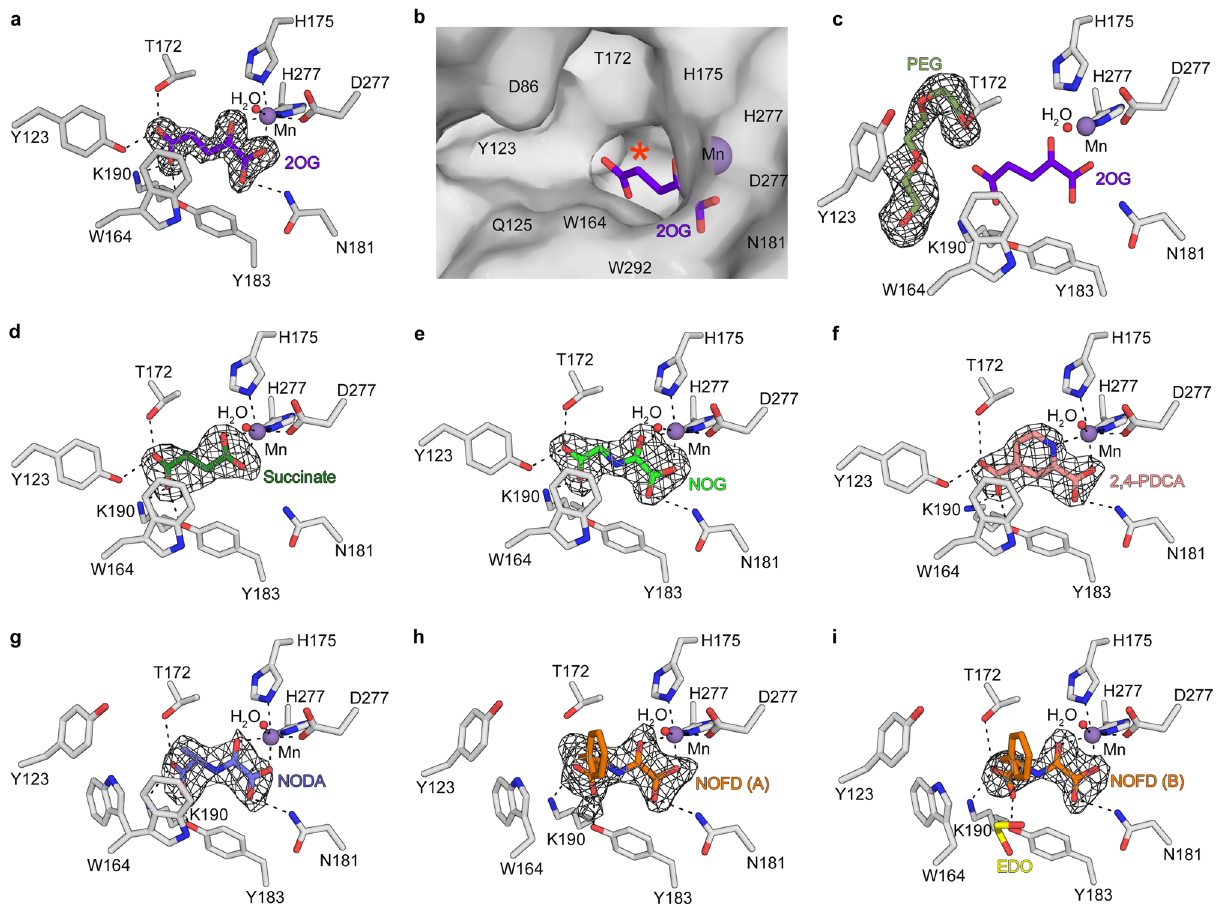
Figure 4. Views from the crystal structures of dmJMJD7.MnII complexes. Active site views from dmJMJD7.2OG ( A , B ), 2OG.PEG ( C ), succinate ( D ), NOG ( E ), 2,4-PDCA ( F ), N-oxalyl- D -alanine (NODA) ( G ), N-oxalyl- D -phenylalanine (NOFD, H , I ) complexes. Meshes represent Fo-Fc OMIT maps contoured to